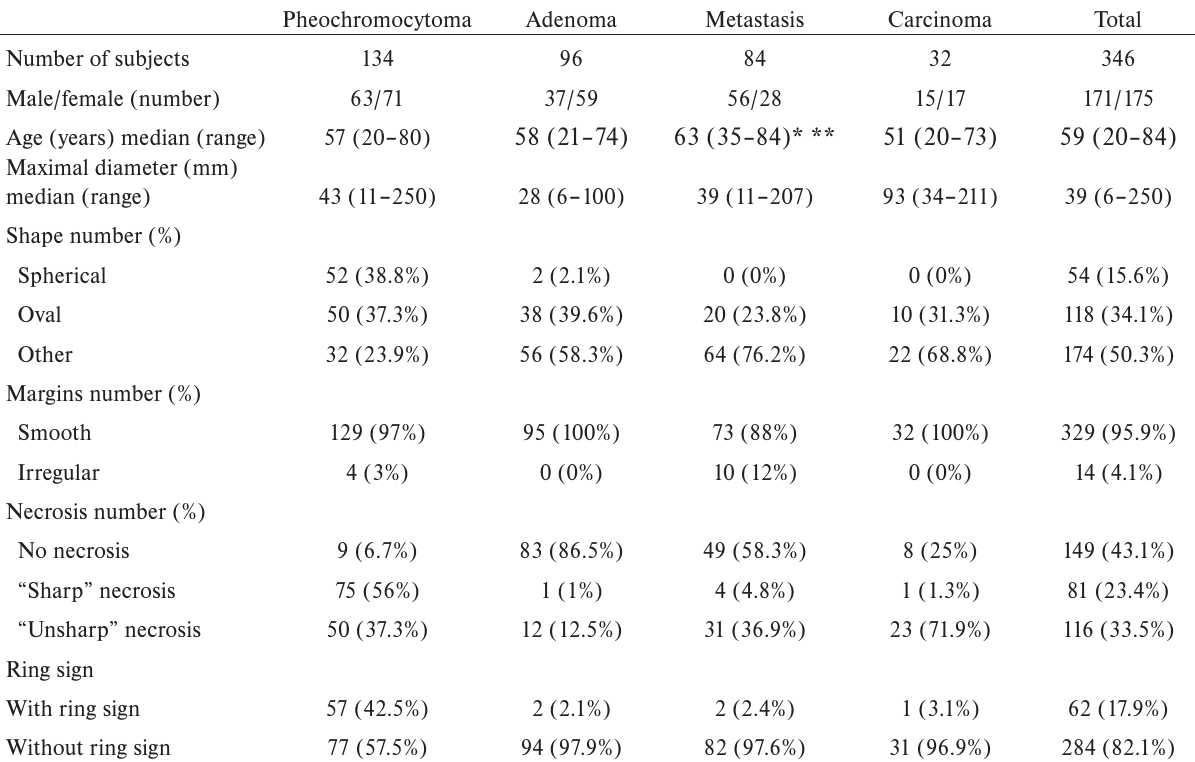
Table 1. The clinical, histological and CT characteristics of the adrenal tumors.